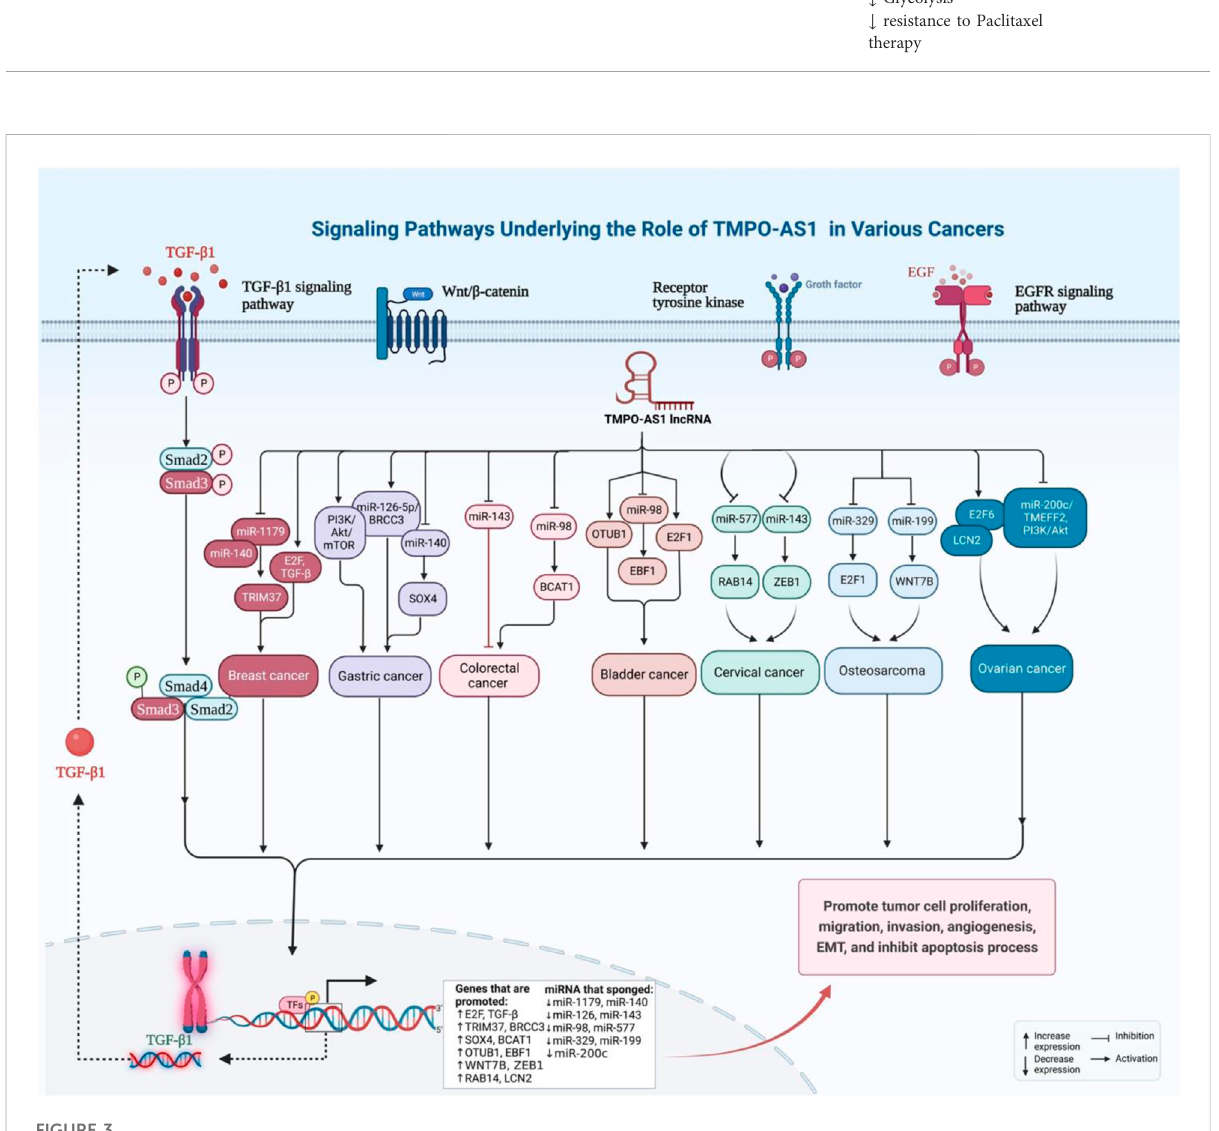
FIGURE 3 Signaling Pathways underlying the role of TMPO-AS1 in Various